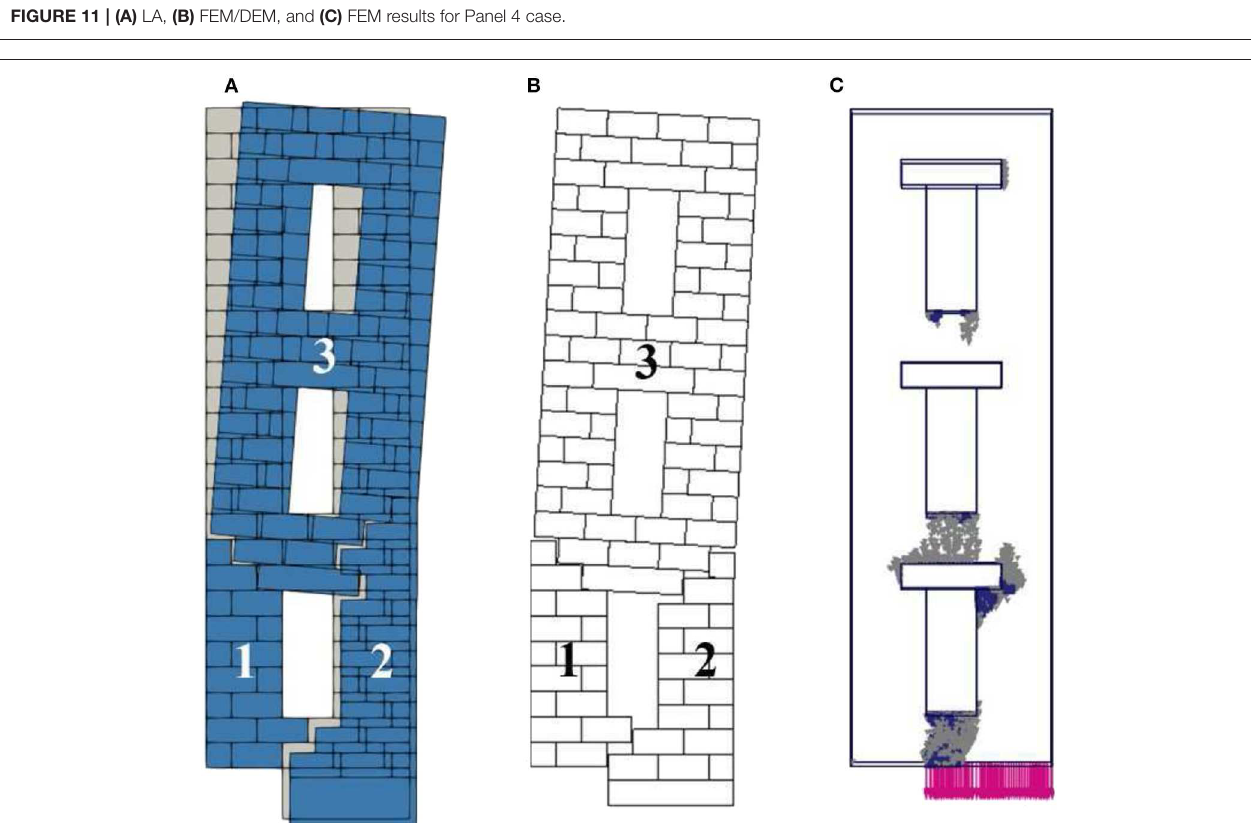
FIGURE 12 | (A) LA, (B) FEM/DEM, and (C) FEM results for Panel 5 case. made up of 320 blocks with dimensions 50 × 100 × 50 mm 3 . The dimension of the fictitious block is 100 × 300 × 50 mm 3 for both the analyzed cases. Façade 1 is affected by a lateral settlement, while Façade 2 is affected by a central